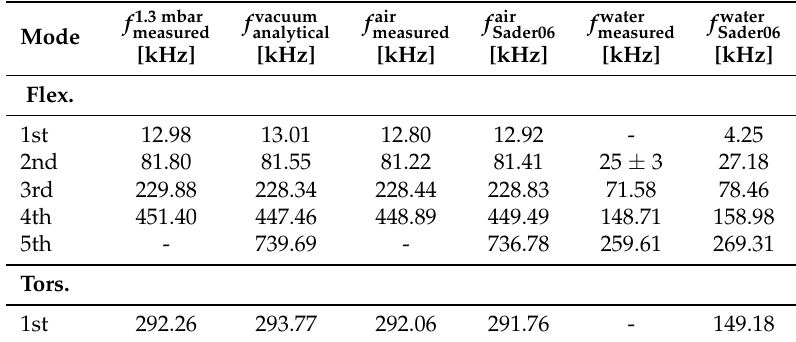
Figure 8. Frequency response of the CONT cantilever in water, air, and vacuum (1.3mbar), measured with the vector network analyzer (VNA). The graph in the bottom left corner shows the response of the cantilever at low frequencies. The blue dashed ellipse surrounds the second resonance frequency in liquid. Table 3. Comparison between the experimentally measured and theoretical [21] resonant frequencies of the CONT cantilever in different environments.